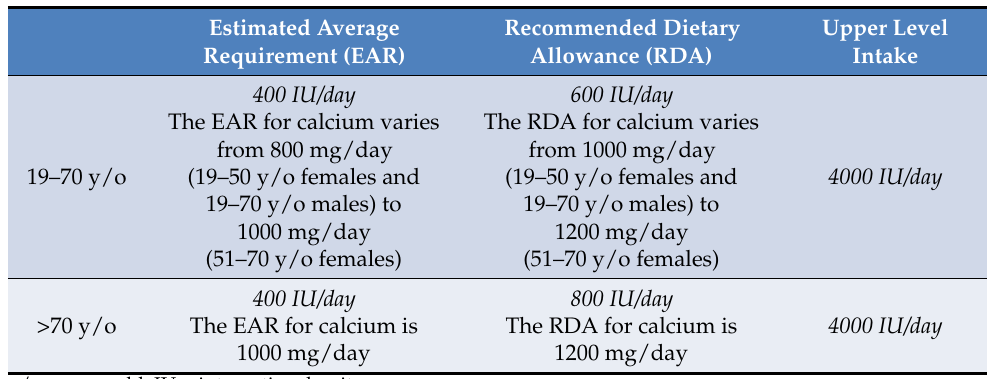
Table 2. Dietary Reference Intakes for Vitamin D (Institute of Medicine). Adapted from references [69,70]. The upper level intake for calcium has not been included since it is much greater than the upper limit considered safe in CKD patients (1000–1200